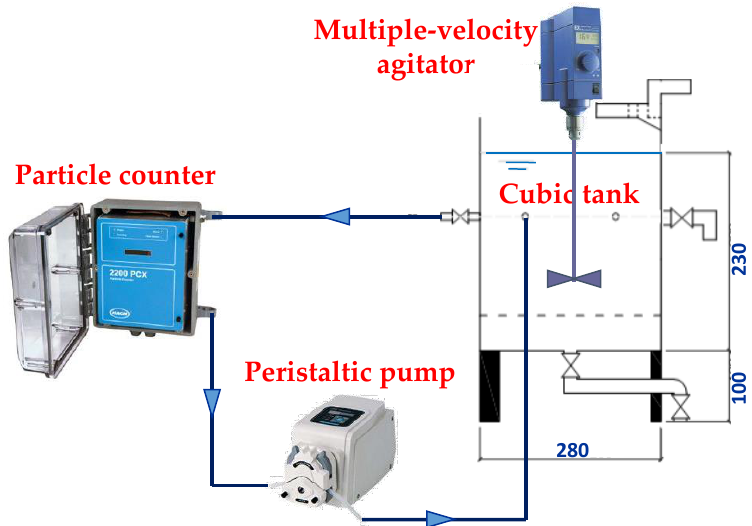
Figure 1. Experimental apparatus (Unit: mm).